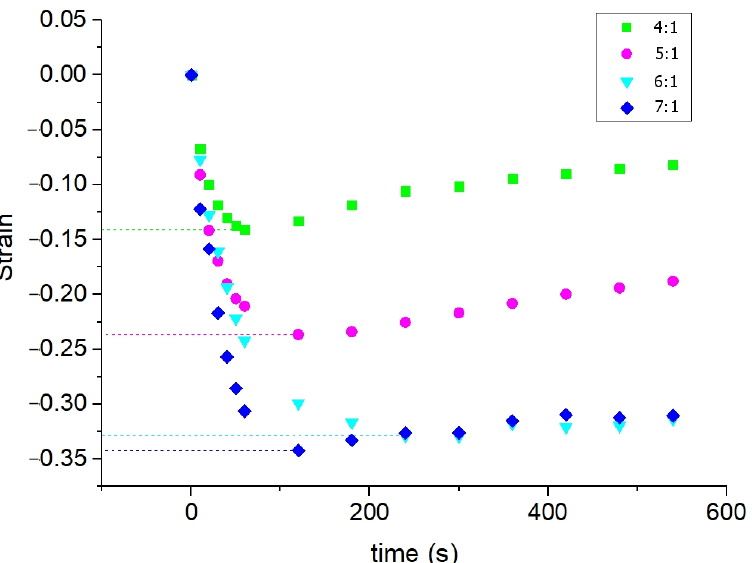
Figure 4. Kinetics of the strain minima for polyacrylamide gels with different crosslinking ratios during their immersion in 50% ( v / v ) water ‐ based glycerol solution. The numerical kinetics are obtained from the “waterfall” OCE data presented in the diagrams in Figure 2.